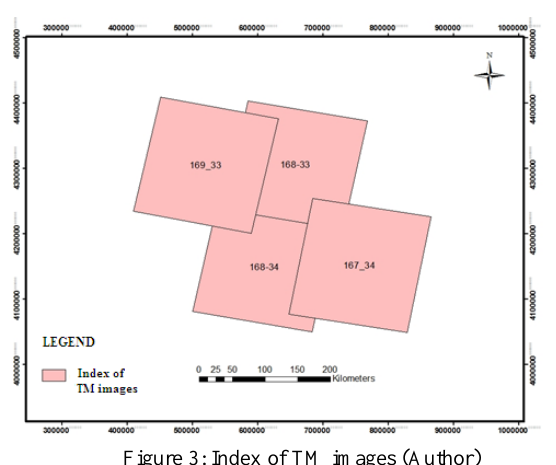
Figure 3: Index of TM images (Author)